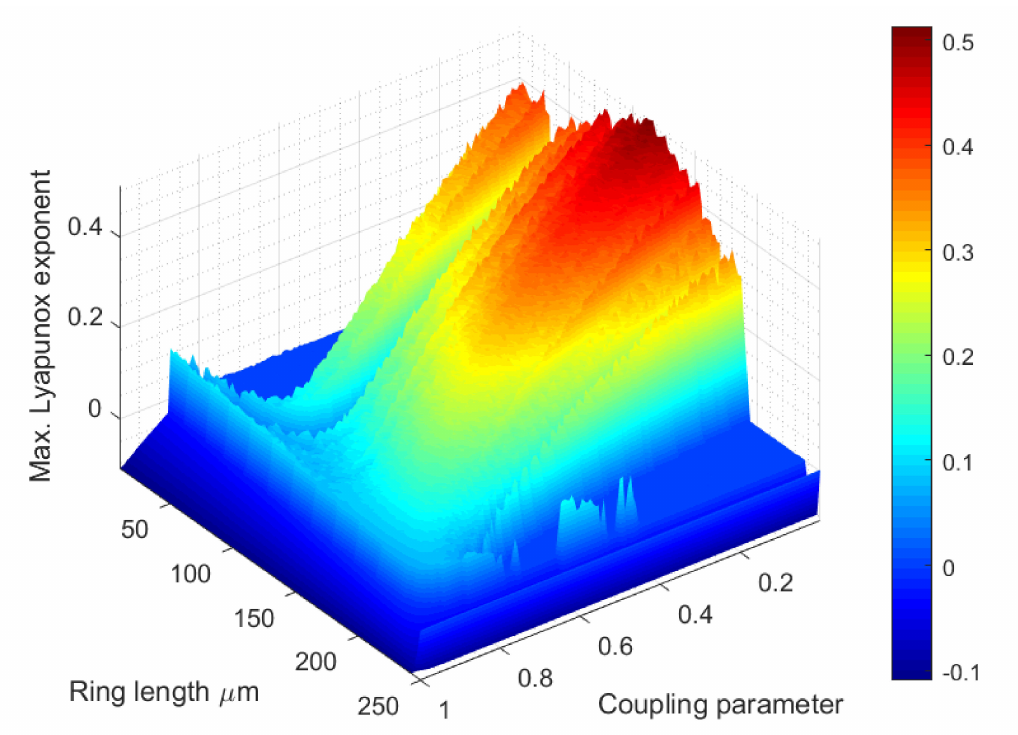
Figure 5. Lyapunov maximum exponent: bidimensional